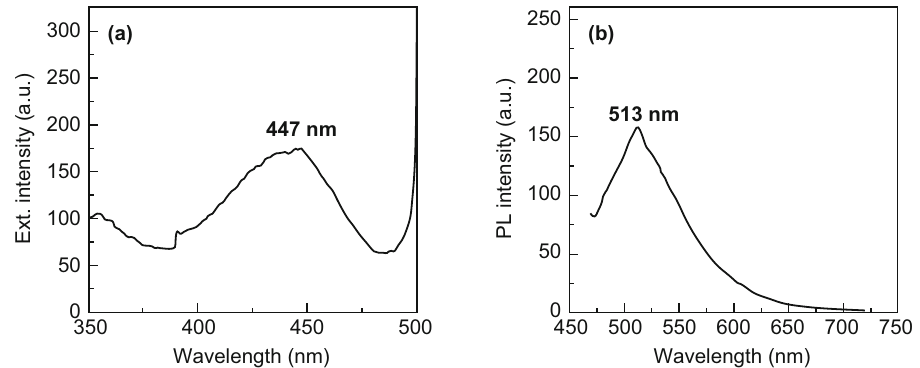
Fig. 8 a Excitation spectrum and b emission spectrum of CH 3 NH 3 PbI 3 nanoparticles. Reproduced with permission Ref. [109]. Copyright (cid:2) 2016 Elsevier